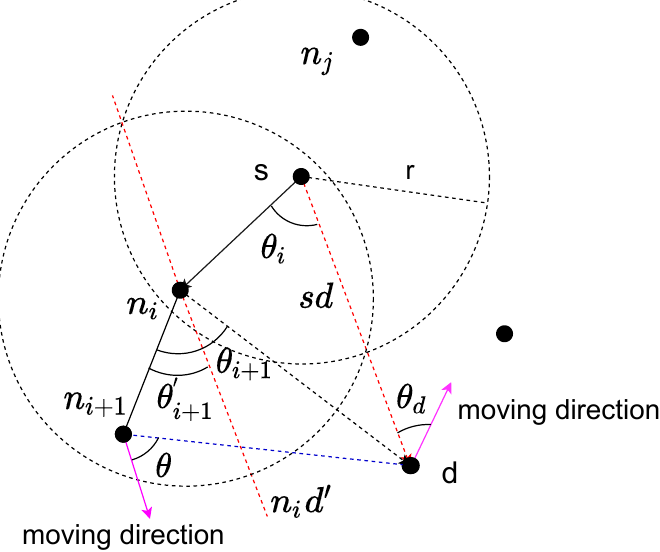
Figure 2. Two-hop based routing between s , n i , and n i + 1